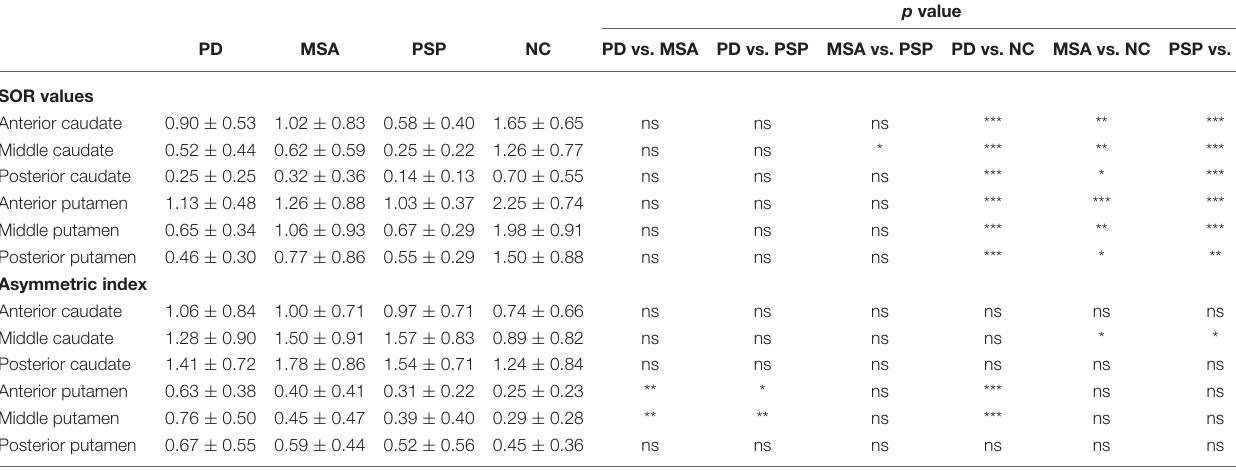
TABLE 2 | Average SOR values and bilateral asymmetric indexes for parkinsonism groups and normal controls (NC).